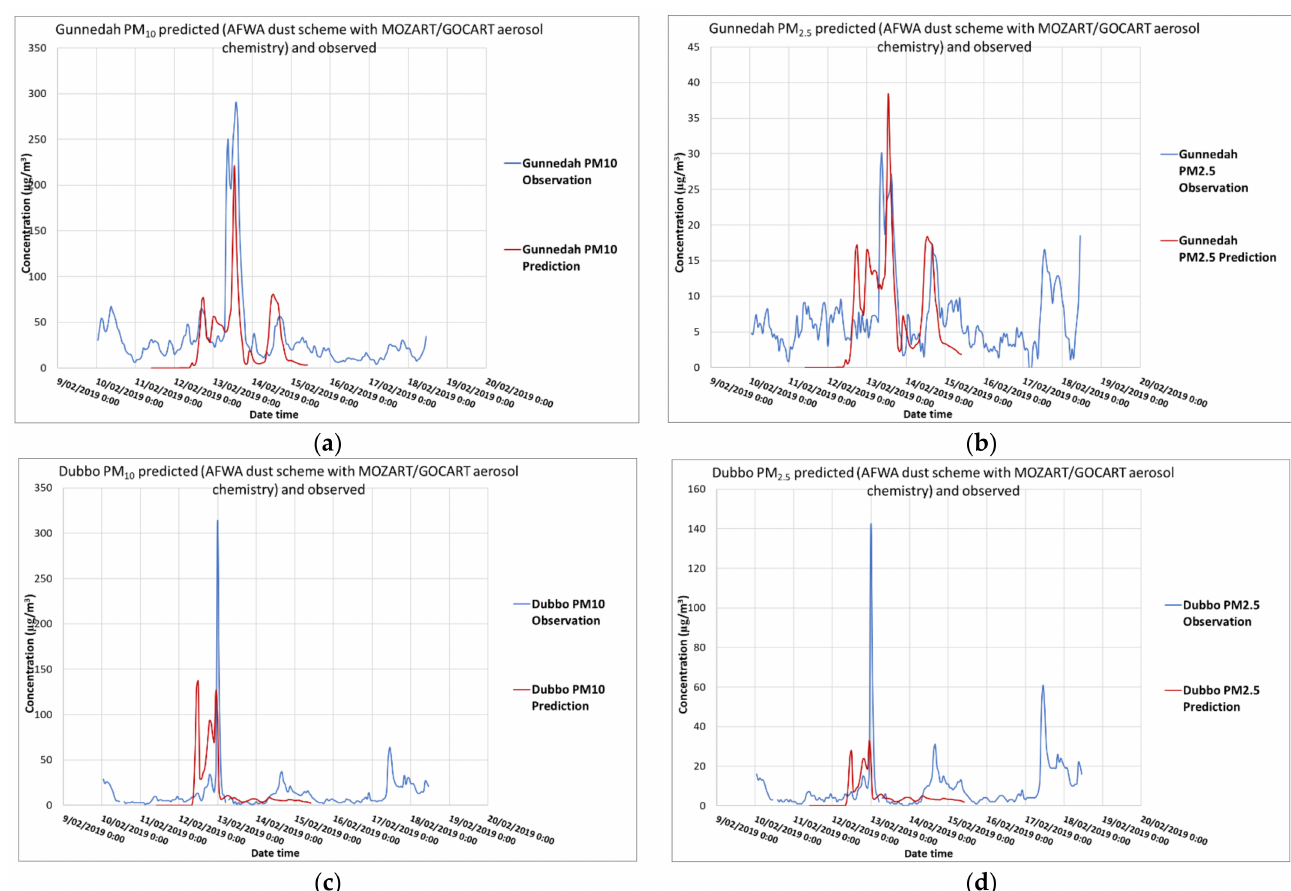
Figure 5. Comparison of PM 10 and PM 2.5 as observed and prediction from WRF-Chem at Gunnedah ( a , b ) and Dubbo ( c , d